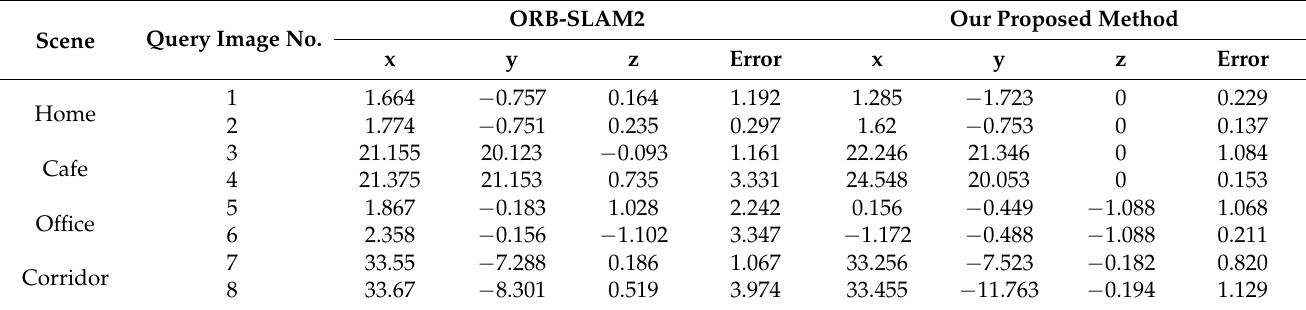
Table 4. Pose estimation result of ORB-SLAM2 method and our proposed method (angle, quaternion form). Scene Query Image No.